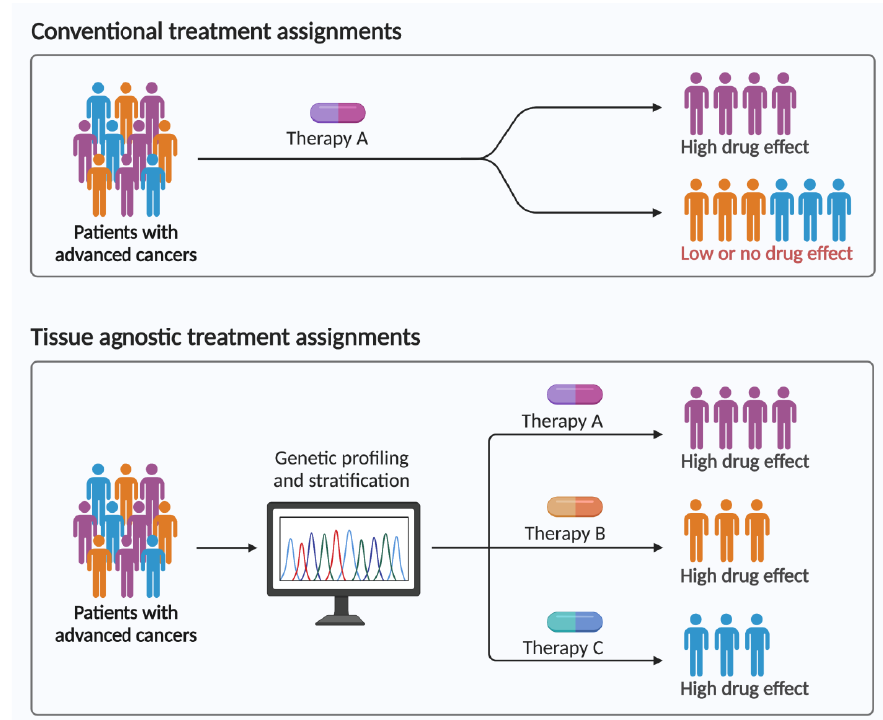
Figure 2. Conventional versus tissue-agnostic trials. Conventional trials often designate all patients with a specific advanced cancer to a drug that may or may not match their cancer genomic alterations. This often leads to a benefit in a select group of patients but not for everyone. Tissue-agnostic basket trials based on genomic alterations specific to a patient’s cancer may lead to more optimal therapy designations and better treatment effects.